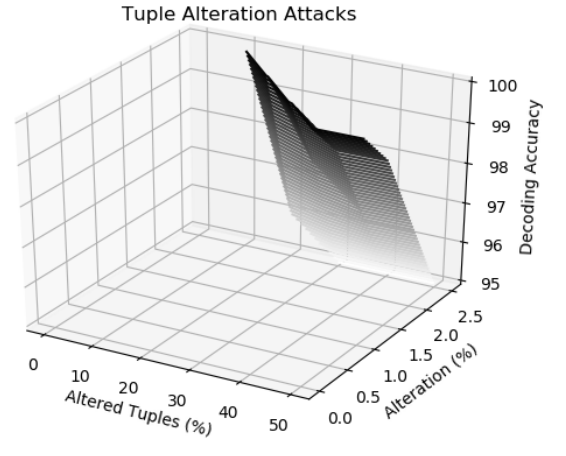
Figure 4. Robustness against tuple alteration attacks.